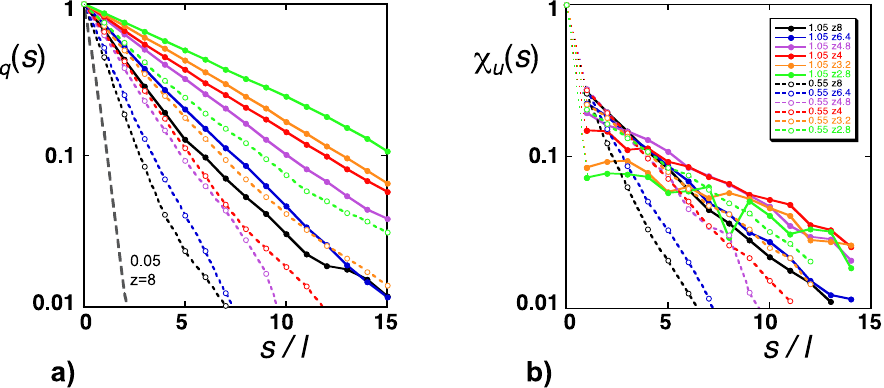
Figure 10. The autocorrelation functions, ( a ) χ q ( s ) and ( b ) χ u ( s ), as functions of the normalized separation distance s / l . These examples correspond to BCC simulations with CV = 0.05 (thick grey dashed line), 0.55 (dotted lines) and 1.05 (solid lines), and to different values of Z as indicated in the inset. The nugget effect characteristic of the χ u ( s ) curves is made more visible by using very thin lines at the beginning of the curves (see text for more